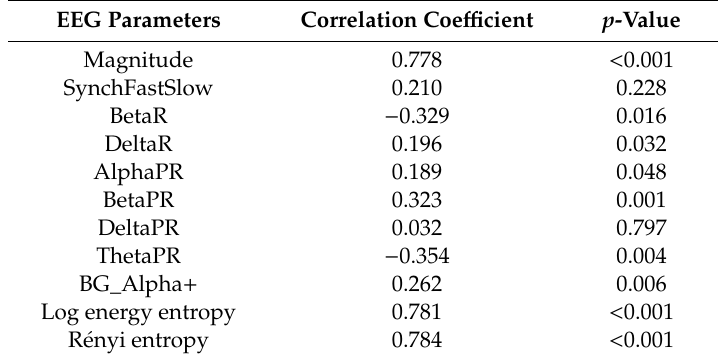
Table 2. Pearson correlation coefficients between EEG parameters and the recovery rates of CBF.